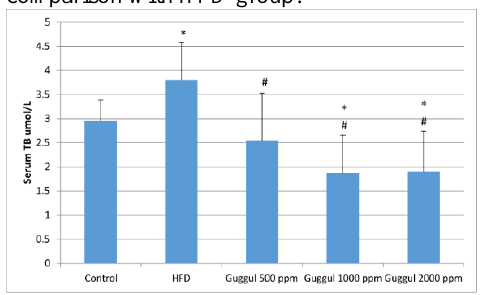
Figure (8) Effects of guggulsterone on serum TB level of mice models with high-fat diet induced NAFLD.